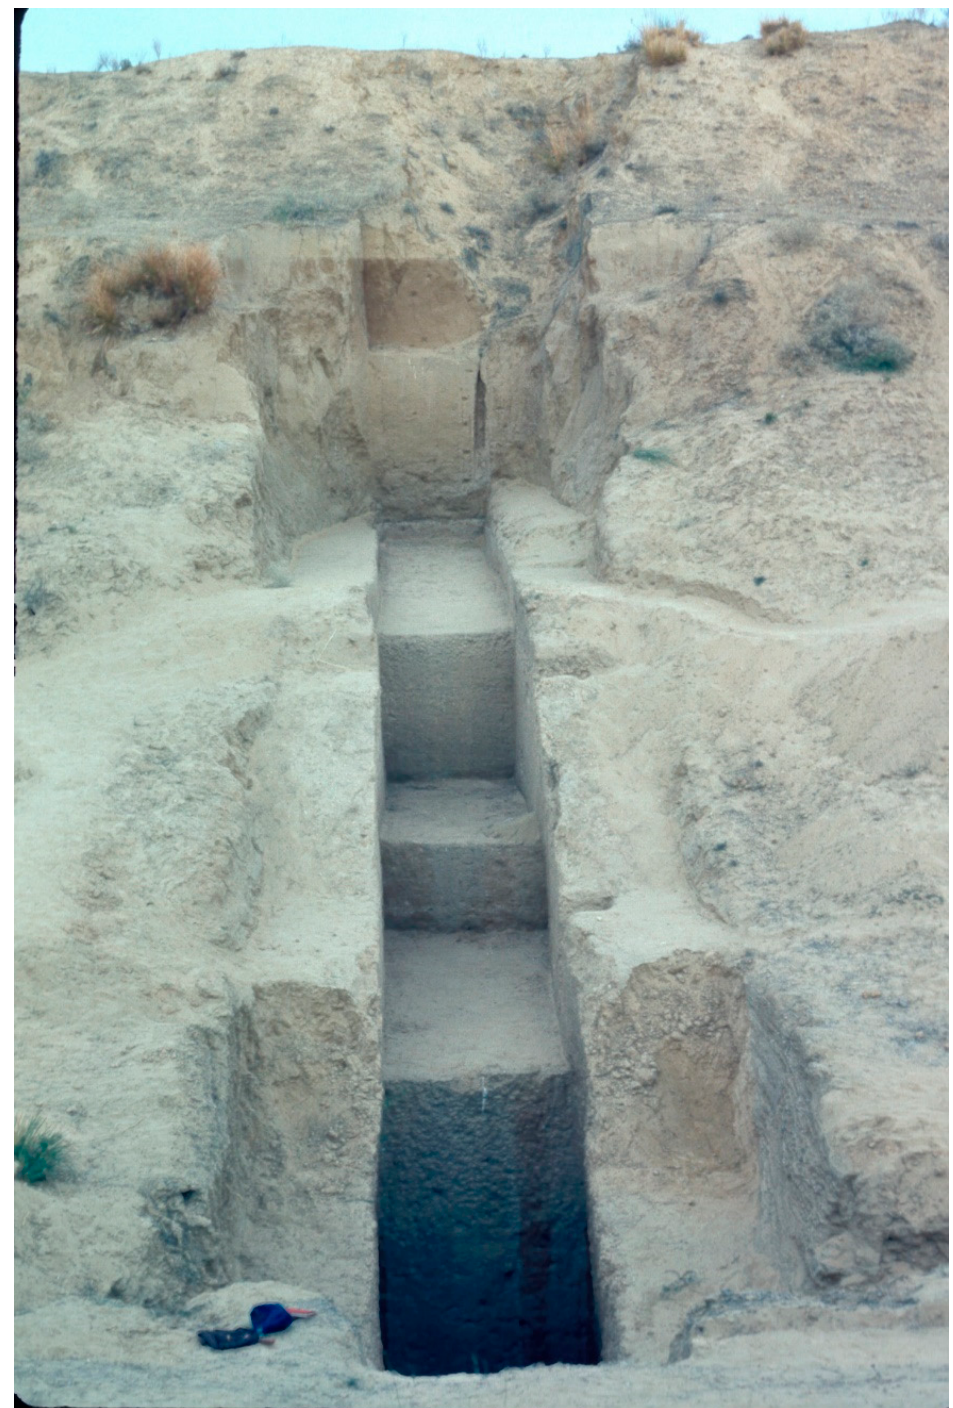
Figure A5. Mesolithic shell midden on the surface of a sand dune in the lower White Nile valley. The site was occupied at least seasonally about 8000 years ago. For details, see [83].